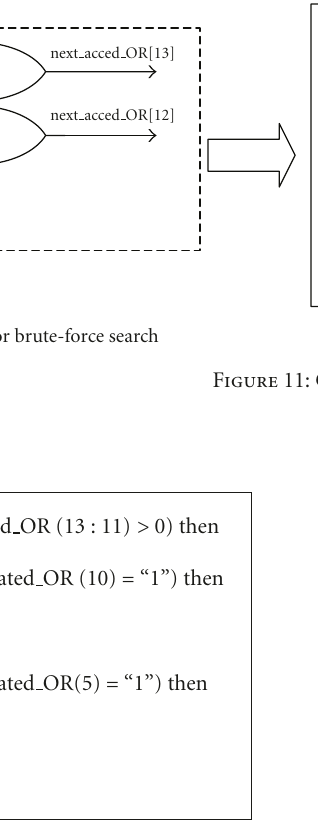
Algorithm 2: Brute-force search and barrel